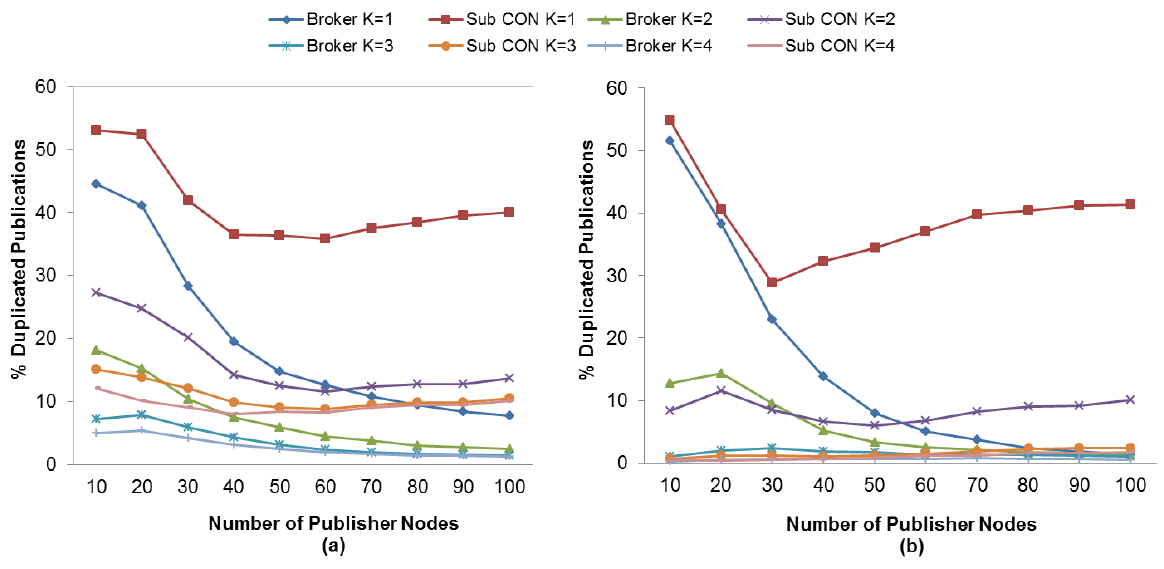
Figure 15. Effect of the number of Publisher nodes on the Duplicated Publications on Broker and Subscriber Nodes depending on the K value of for RTO without ( a ) and with ( b ) MAC Acknowledgments.